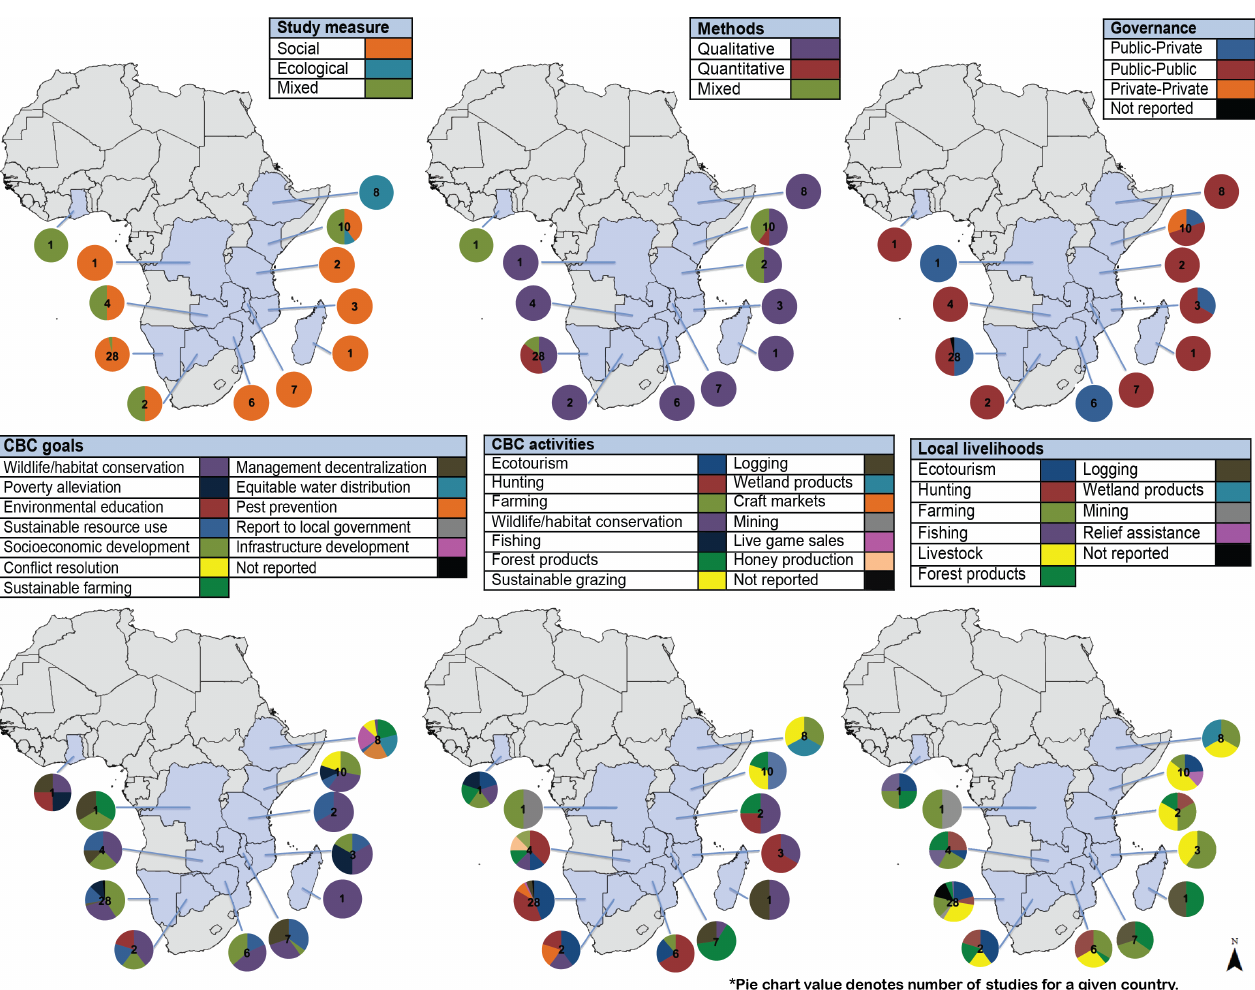
Fig. 5 . Multiple map inset. Study measures for community-based conservation (CBC) research: social (54 studies; 74%), mixed ([i.e., social and ecological] 10 studies; 14%), ecological (9 studies; 12%). Study methods for CBC research: qualitative (51 studies; 70%), quantitative (12 studies; 16%), mixed ([i.e., qualitative and quantitative] 10 studies; 14%). Community-based conservation governance: public-public (45 studies, 62%), public-private (24 studies; 33%), private-private (3 studies; 4%), not reported (1 study; 1%). Community-based conservation goals: wildlife/habitat conservation (47 studies; 64%), poverty alleviation (12 studies; 16%), environmental education (2 studies; 3%), sustainable resource use (24 studies; 33%), socioeconomic development (39 studies; 53%), conflict resolution (9 studies; 12%), sustainable farming (9 studies; 12%), management decentralization (10 studies; 14%), equitable water distribution (8 studies; 11%), pest prevention (8 studies; 11%), report to local government (1 study; 1%), infrastructure development (8 studies; 11%), not reported (1 study; 1%). Community-based conservation activities: ecotourism (43 studies; 59%), hunting (37 studies; 51%), farming (12 studies; 16%), wildlife/habitat conservation (8 studies; 11%), fishing (1 study; 1%), forest products (14 studies; 19%), sustainable grazing (14 studies; 19%), logging (7 studies; 10%), wetland products (8 studies; 11%), craft markets (6 studies; 8%), mining (1 study; 1%), live game sales (1 study; 1%), honey production (1 study; 1%), not reported (1 study; 1%). Local livelihoods: livestock (46 studies; 63%), farming (45 studies; 62%), ecotourism (21 studies; 29%), hunting (16 studies; 22%), forest products (18 studies; 25%), fishing (4 studies; 5%), logging (7 studies; 10%), wetland products (8 studies; 11%), mining (3 studies; 4%), not reported (8 studies; 11%), relief assistance (3 studies;